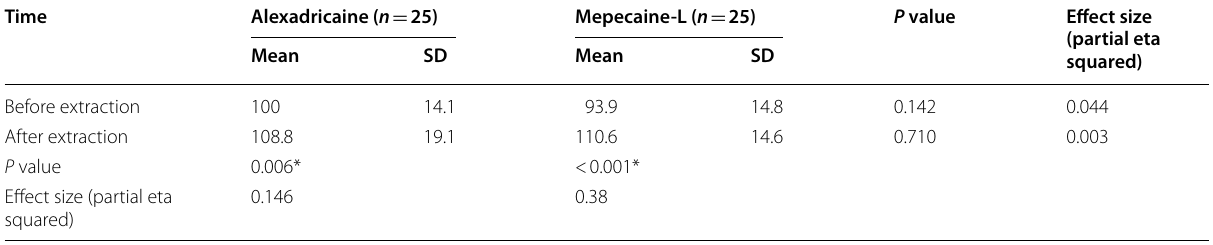
*Significant at P